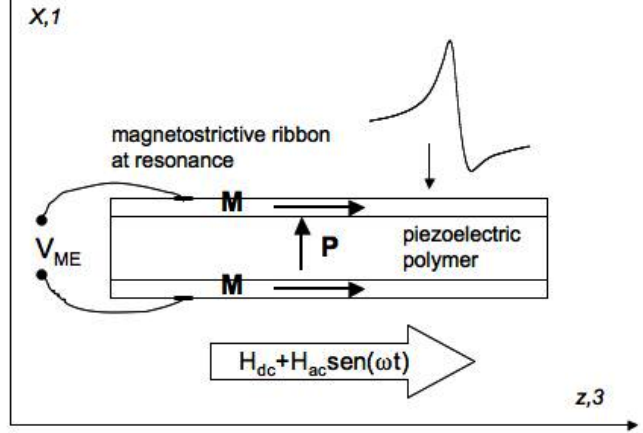
Figure 13. Geometry of the three-layer L-T sandwich configuration: magnetostrictive ribbons are longitudinally magnetized while the piezoelectric polymers were transversely